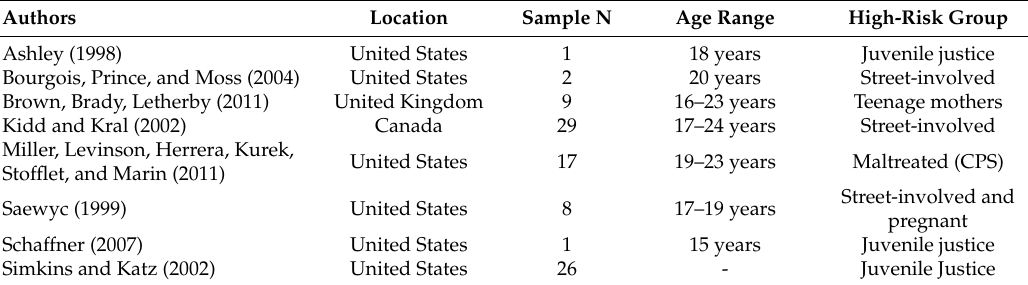
Table 2. Summary of Meta-Synthesis Sample Characteristics